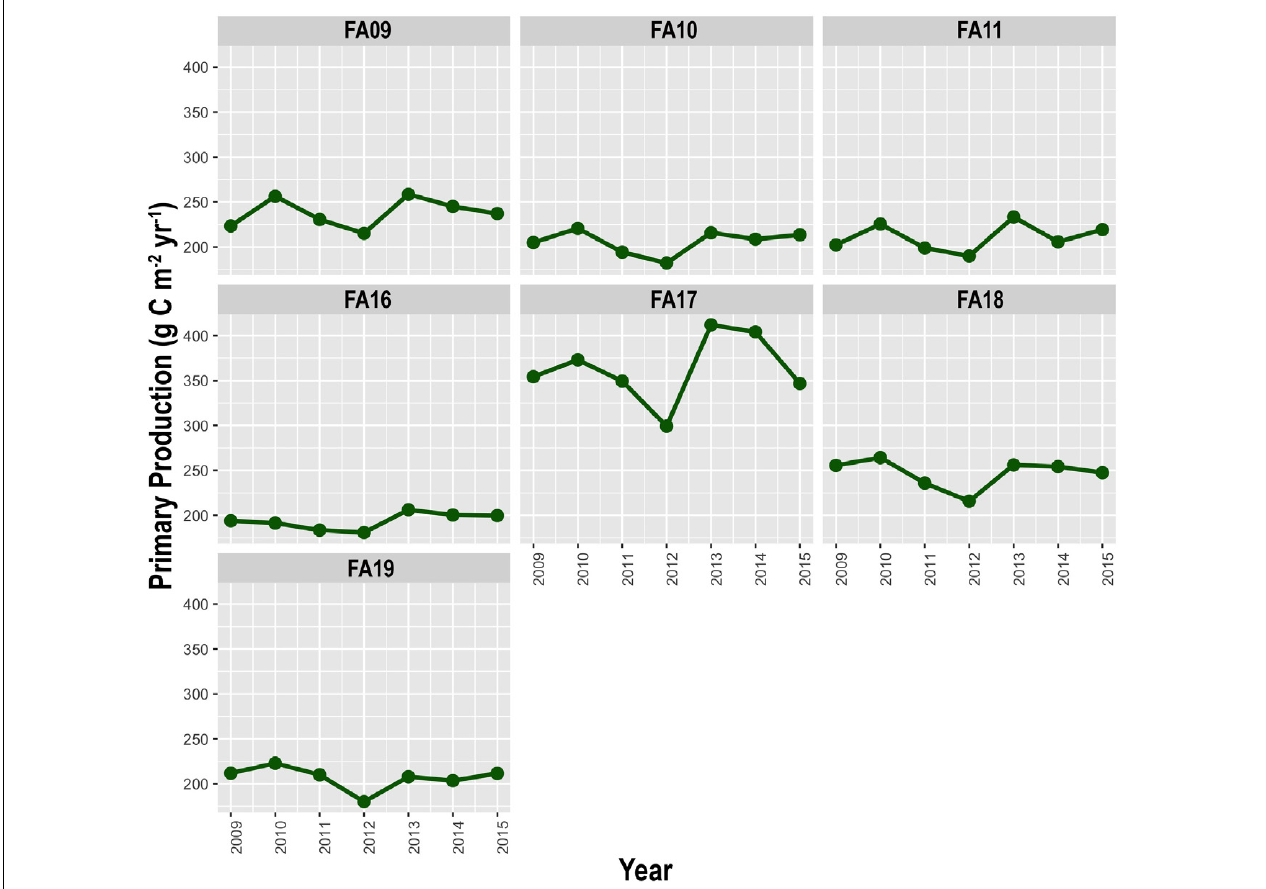
FIGURE 6 | Trends for Primary Production rate (PP in g C m − 2 yr − 1 ) by FA, as reconstructed using the VGPM approach (data available online at the Ocean Productivity Website